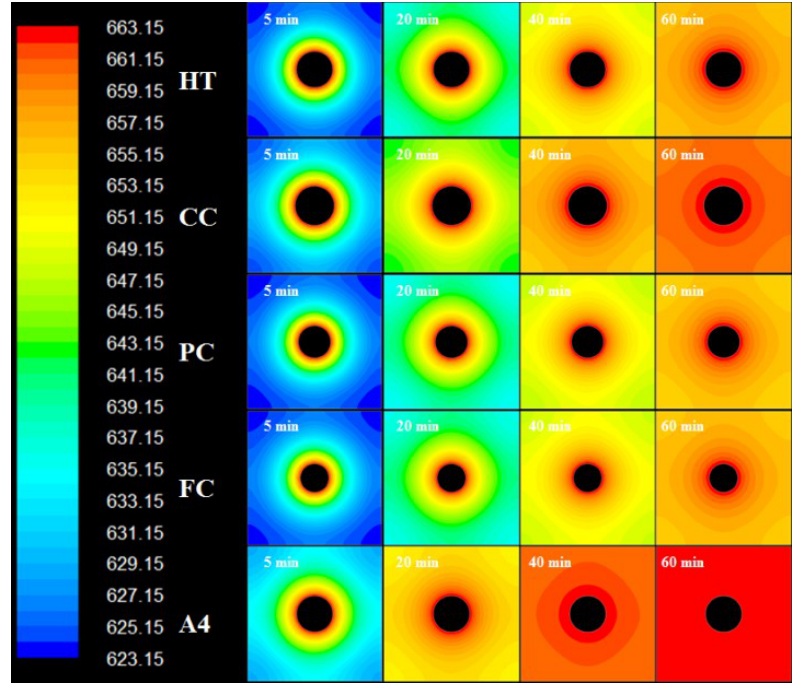
, charge phase. nom